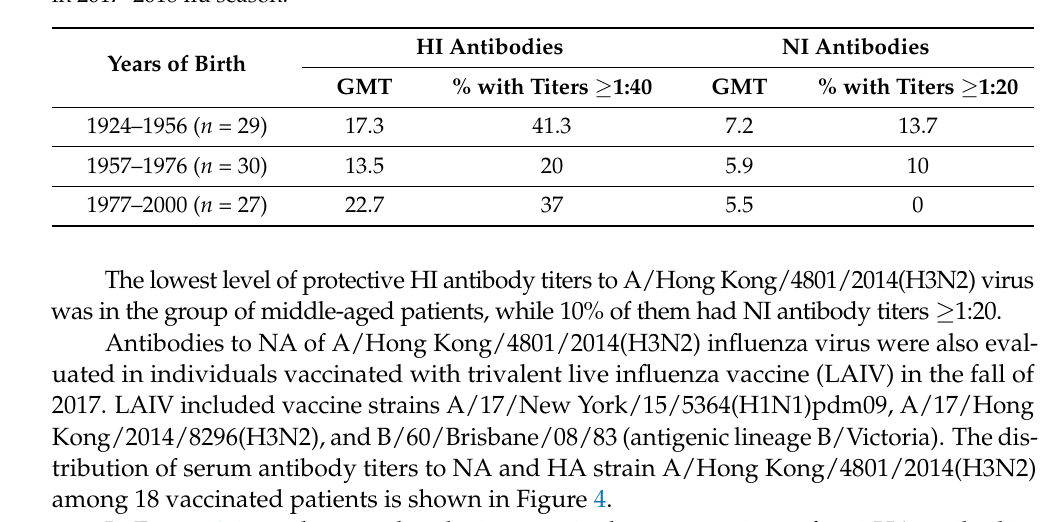
Table 2. The level of herd immunity to antigens to HA and NA of A/Hong Kong/4801/2014(H3N2) in 2017–2018 flu